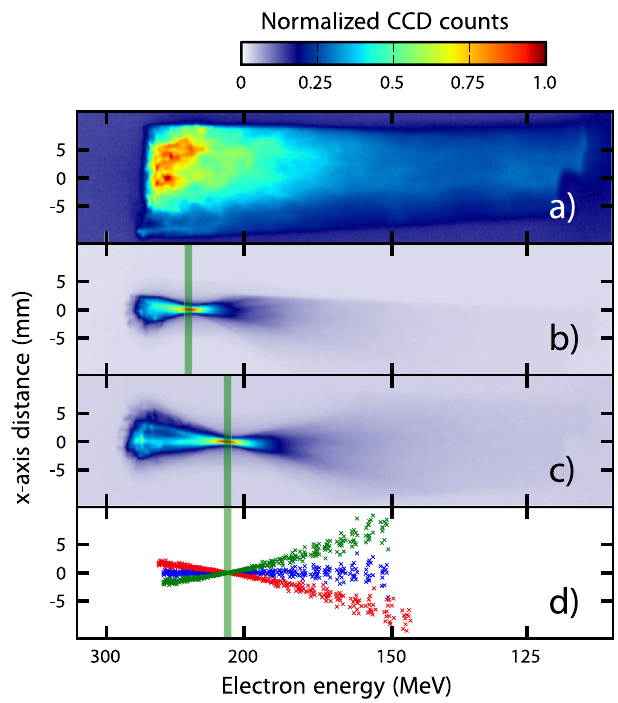
FIG. 3. Electron beam focusing: False color images of summed electron beam spectra observed at S2 (experimental subfigures are each normalized to one). (a) Sum of 20 consecu- tive shots without magnetic lenses. (b) Sum of 44 shots, focus at 230 MeV. (c) Sum of 30 shots, focus at 210 MeV. Vertical green lines indicate the intended electron energy to be focused at the screen position. As in Fig. 2(b), the summed beam size is reduced for a broad range of electron energies. (d) Simulation with lenses positioned as in (c) for electron beams with energies 150—250 MeV with initial divergence of 1.7 mrad FWHM for ) leaving the gas cell: three different initial pointing angles ( (cid:3) x;y ¼ 0 (blue), (cid:3) ¼ (cid:3) ¼ 3 : 6 mrad (red), on-axis beam (cid:3) x;y x y ¼ (cid:5) 3 : 6 mrad (cid:3) ¼ 0 (cid:3) x y